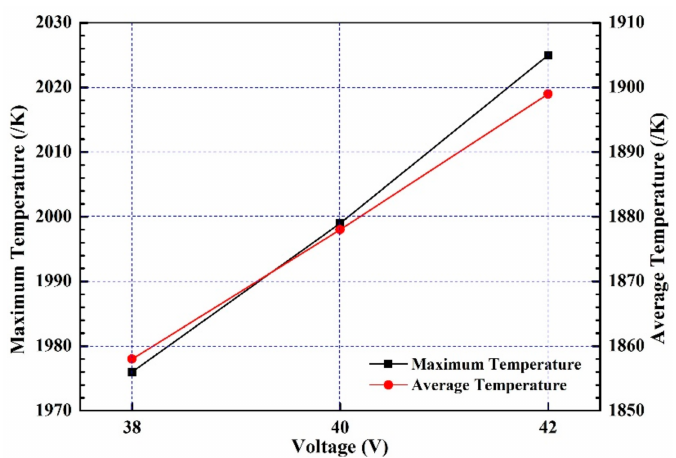
Figure 9. Evolution of the maximum and average temperature of the slag pool with different voltage.